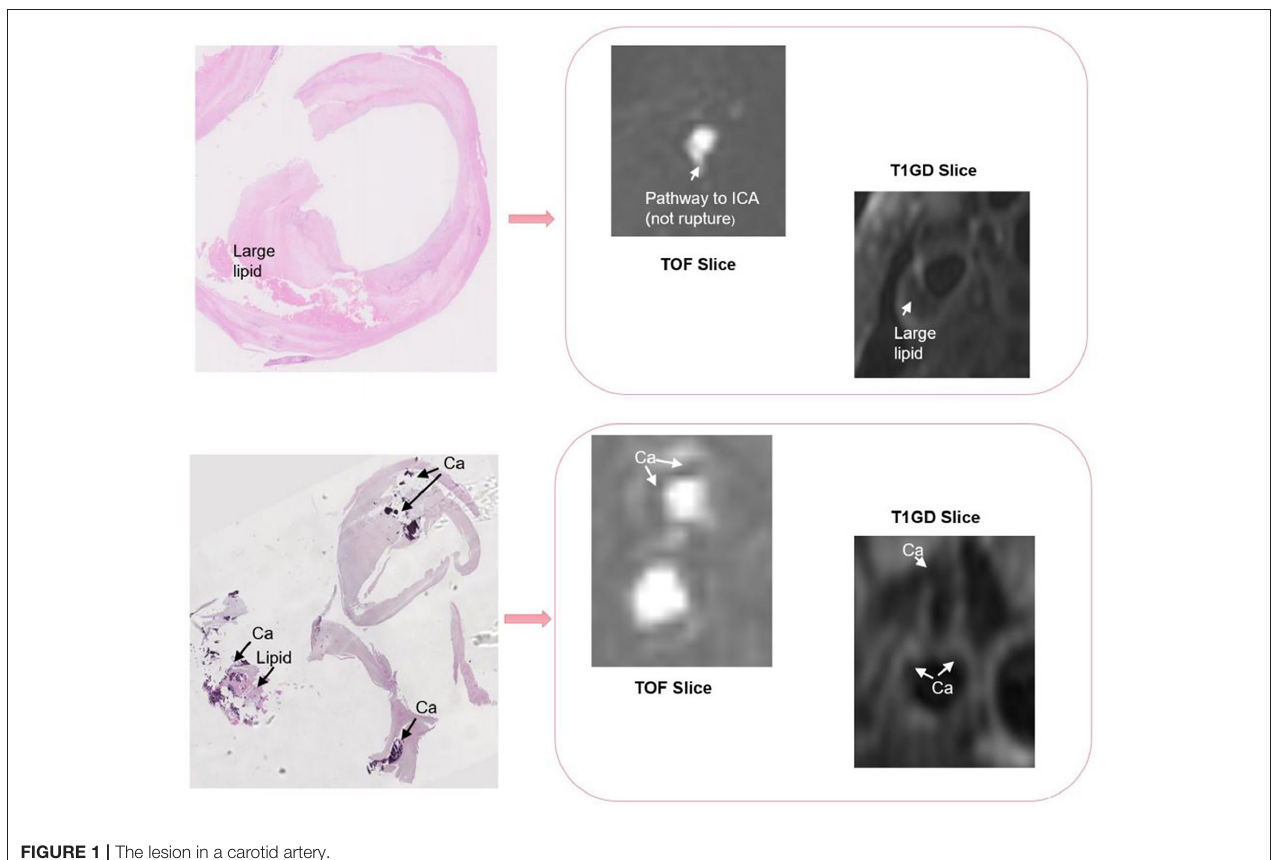
FIGURE 1 | The lesion in a carotid artery.